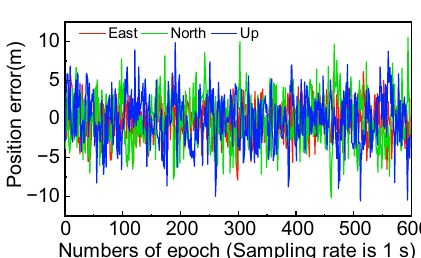
Fig. 13 Errors of dynamic Doppler positioning solution in the east (E), north (N) and up (U)